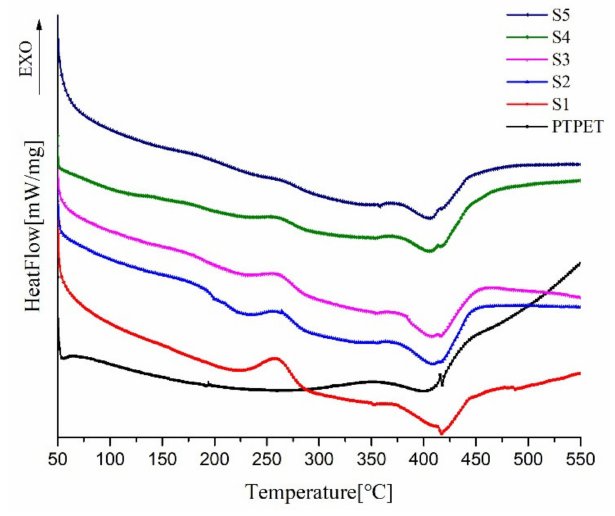
Figure 7. DSC curves of PTPET and S1–S5. Table 3. Peak temperature of DSC curves.